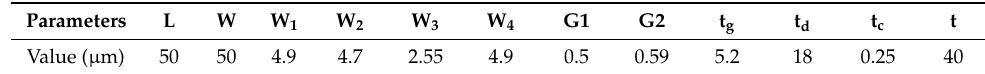
Figure 1. Structure of the THz sensor ( a ) Top view ( b ) Top view of unit cell ( c ) Side view ( d ) Perspec- tive view. Table 1. Dimension details of graphene-based THz